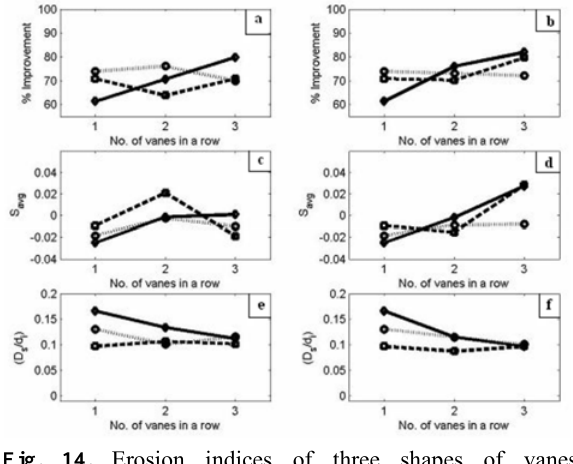
Fig. 14. Erosion indices of three shapes of vanes ( −−●−− flat,—— ◊ —— curved and ....o…. angled) at different arrays of parallel (a,c,& e) and zigzag (b, d &